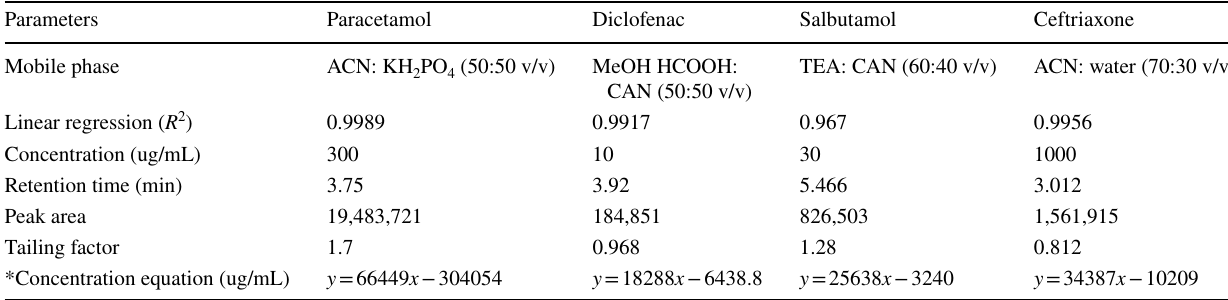
Table 3 Summary of calibration and standard results of HPLC analysis